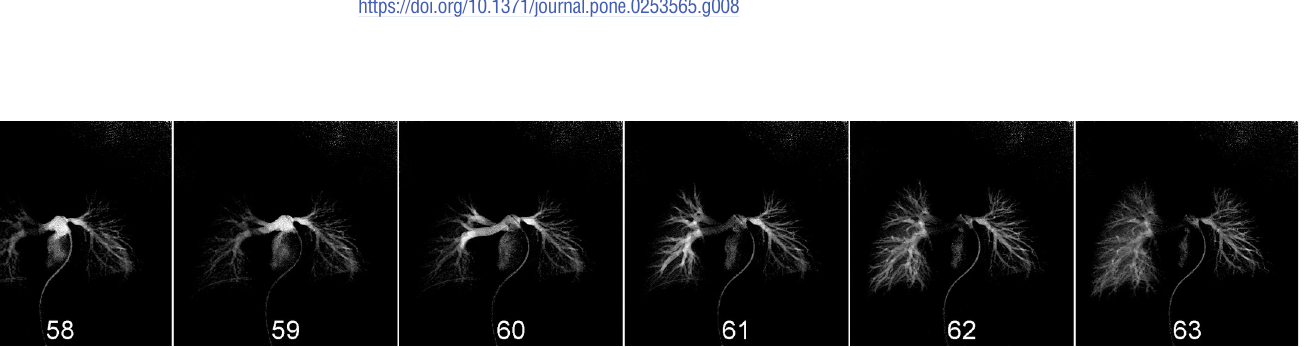
PLOS ONE | https://doi.org/10.1371/journal.pone.0253565 June 29,